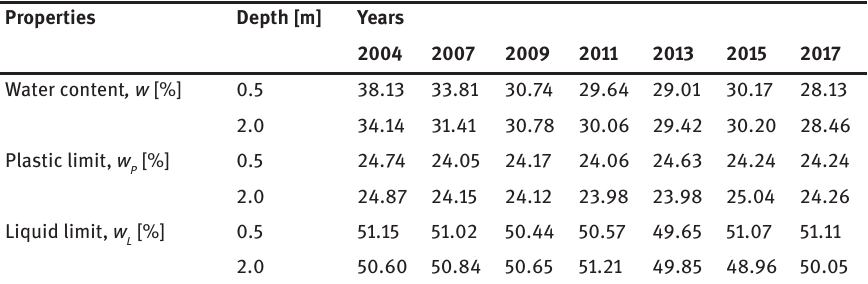
used in the stability calculations. L